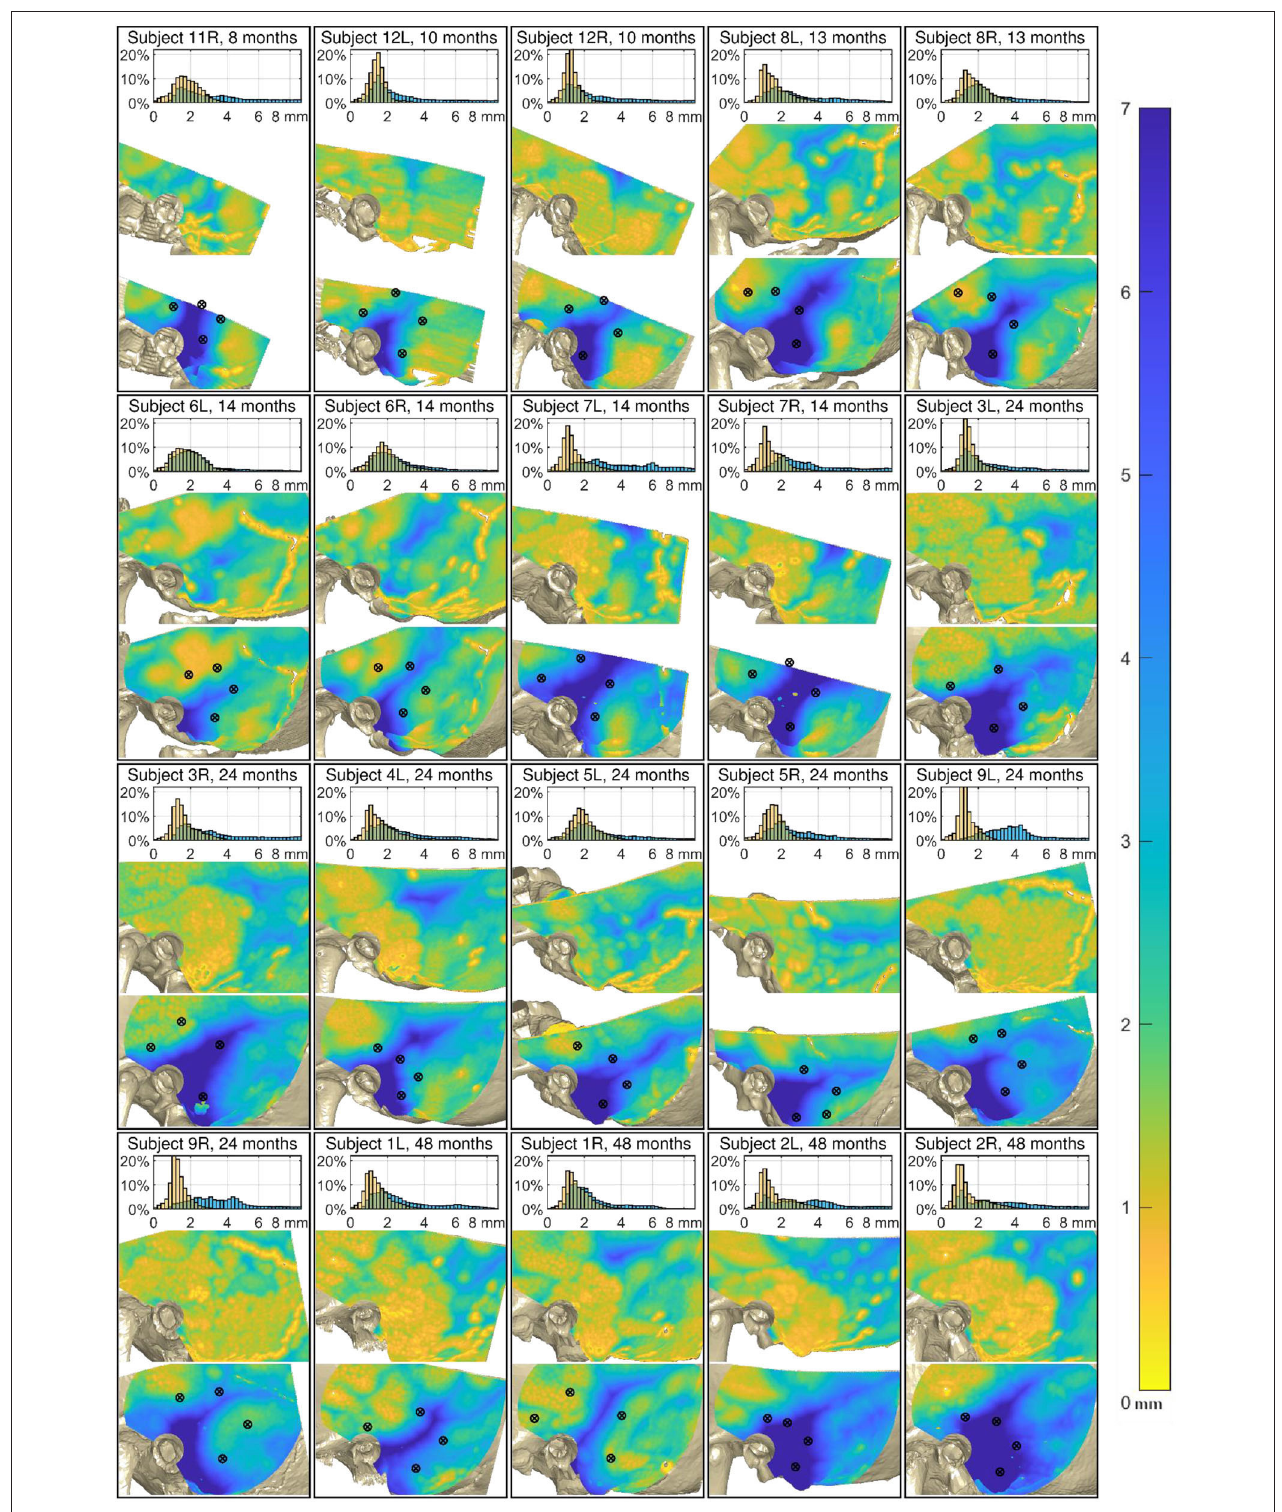
FIGURE 4 | Analysis of the 20 cases. Top of each case: Relative distribution of the cortical layer thickness (CLT, orange) and the distance to the dura or venous sinuses (DDVS, light blue). Middle: The thickness of the cortical layer. Bottom: The distance to the dura or the venous sinuses. The black markers designate the locations where the fiducial screws were placed. The maps of all subjects are aligned relative to the external auditory canal and temporal line.